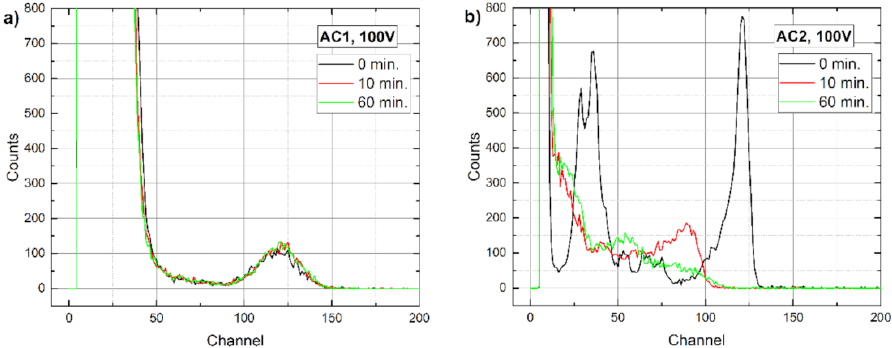
Figure 9. Time evolution of Am 241 spectra measured at 100 V on ( a ) AC1 and ( b ) AC2 samples.